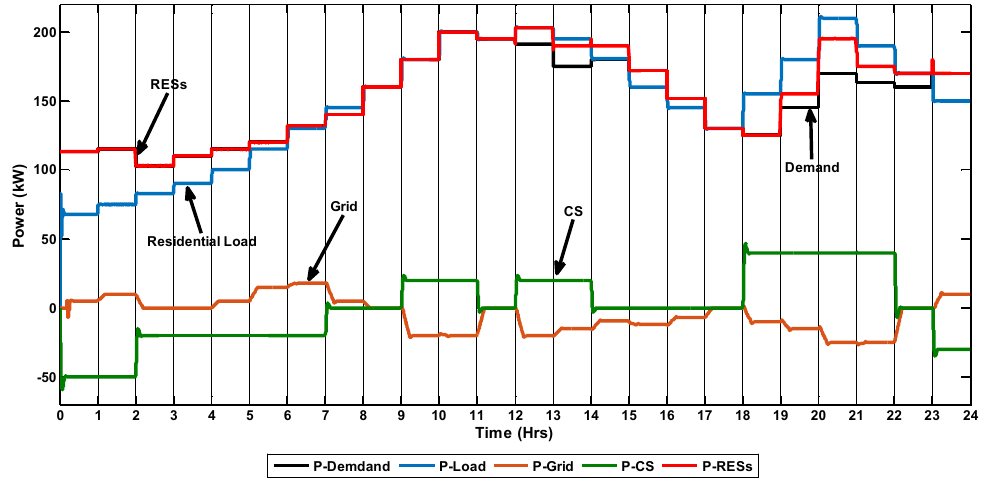
Figure 9. Power of all the energy sources and total demand in the proposed micro-grid.